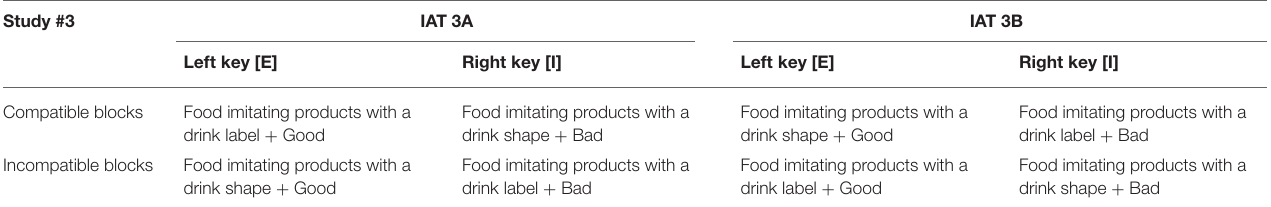
TABLE 5 | Response mappings in IATs 3A and